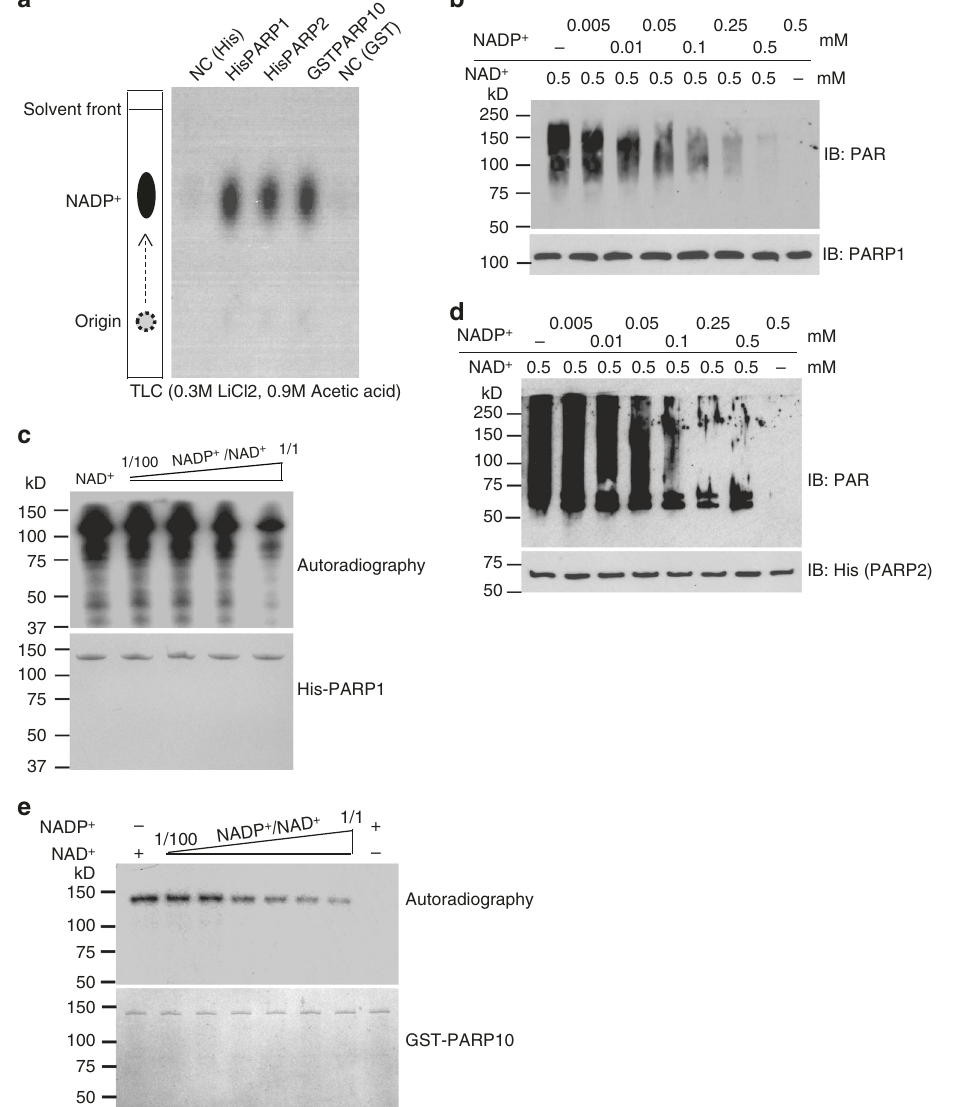
Fig. 3 NADP + suppresses poly(ADP-ribose) polymerase (PARP) activity in vitro. a PARPs can bind to NADP + . HIS-PARP1, HIS-PARP2, and GST-PARP10 were immobilized on Ni Sepharose and glutathione S -transferase (GST) beads respectively, followed by incubating with [ 32 P]NADP + . [ 32 P]NADP + was heat-released from Ni Sepharose or GST beads and examined by thin-layer chromatography. As the negative controls (NC), Ni Sepharose or GST beads without recombinant PARP proteins was incubated with [ 32 P]NADP + . b , c NADP + suppresses PARP1 ’ s activity in vitro. In vitro PAPR1-mediated PARylation assay was performed using different ratio of NADP + /NAD + . Auto-PARylation of PARP1 was examined by western blotting ( b ). [ 32 P]NAD + was used as the donor in PARP1-mediated in vitro PARylation assay. The auto-PARylation of PARP1 was examined by autoradiography. Coomassie staining of His-PARP1 was shown as the loading control ( c ). d NADP + suppresses PARP2 in vitro. Auto-PARylation of PARP2 was examined by western blotting with the indicated antibody. e NADP + suppresses PARP10 in vitro. Auto-MARylation level of PARP10 was examined by